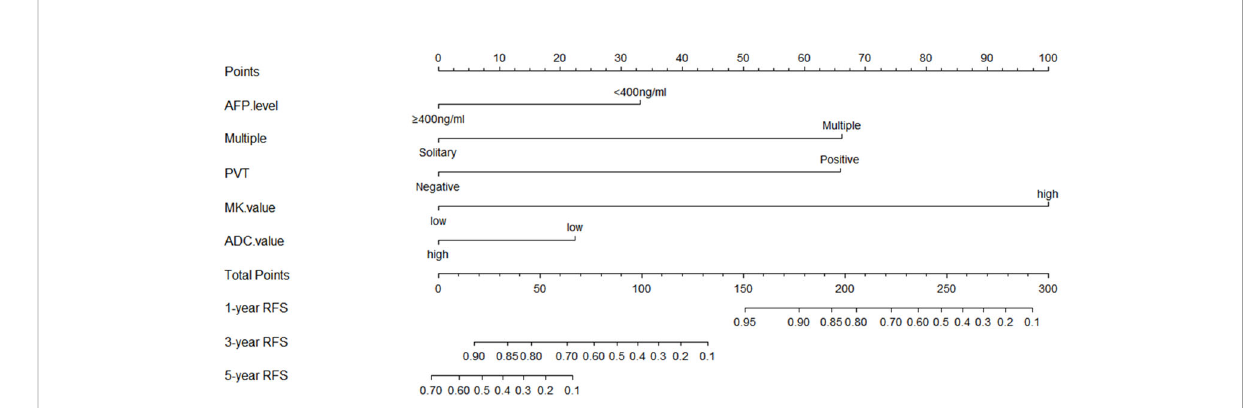
FIGURE 6 Prognostic nomogram graph for recurrence-free survival. PVT, portal vein tumor; RFS, recurrence-free